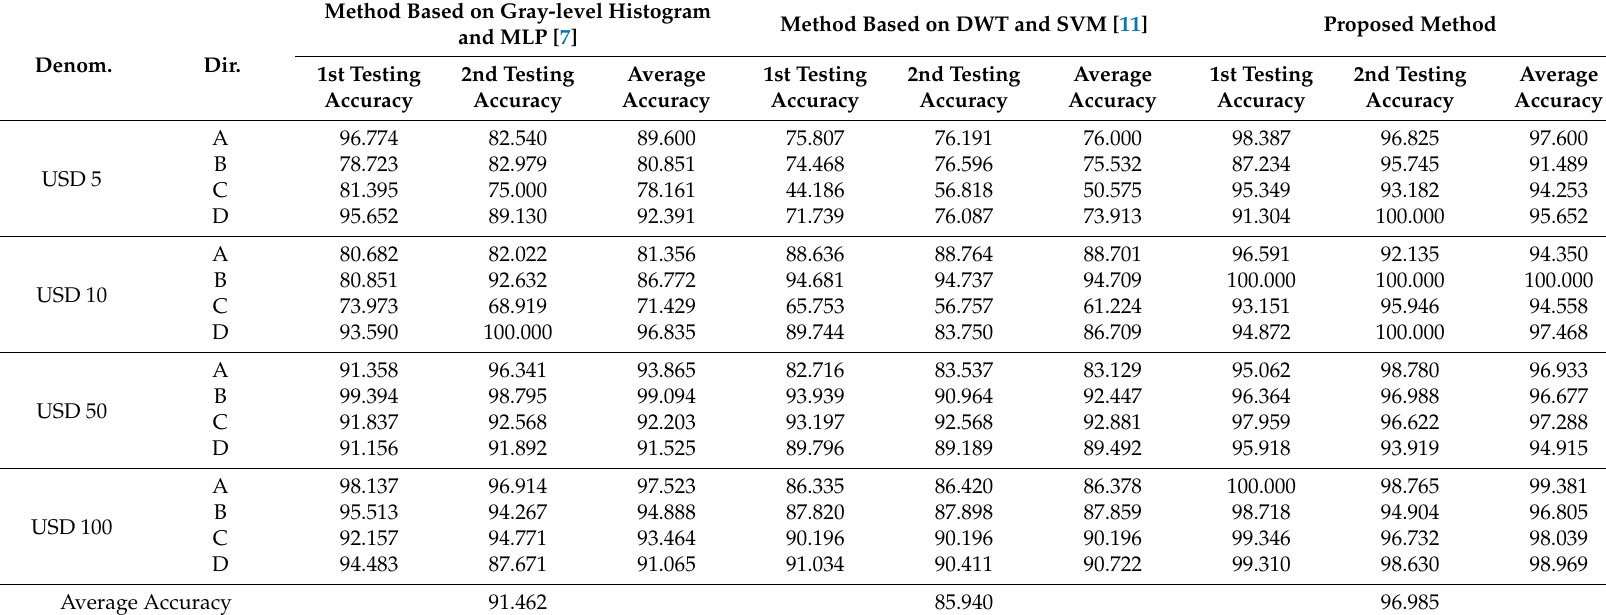
Table 9. Comparison of fitness-classification accuracy by our proposed method with that of previous studies on the USD banknote dataset. Denom., Dir., 1st Testing Results and 2nd Testing Results mean the same as those in Table 7 (unit: %).